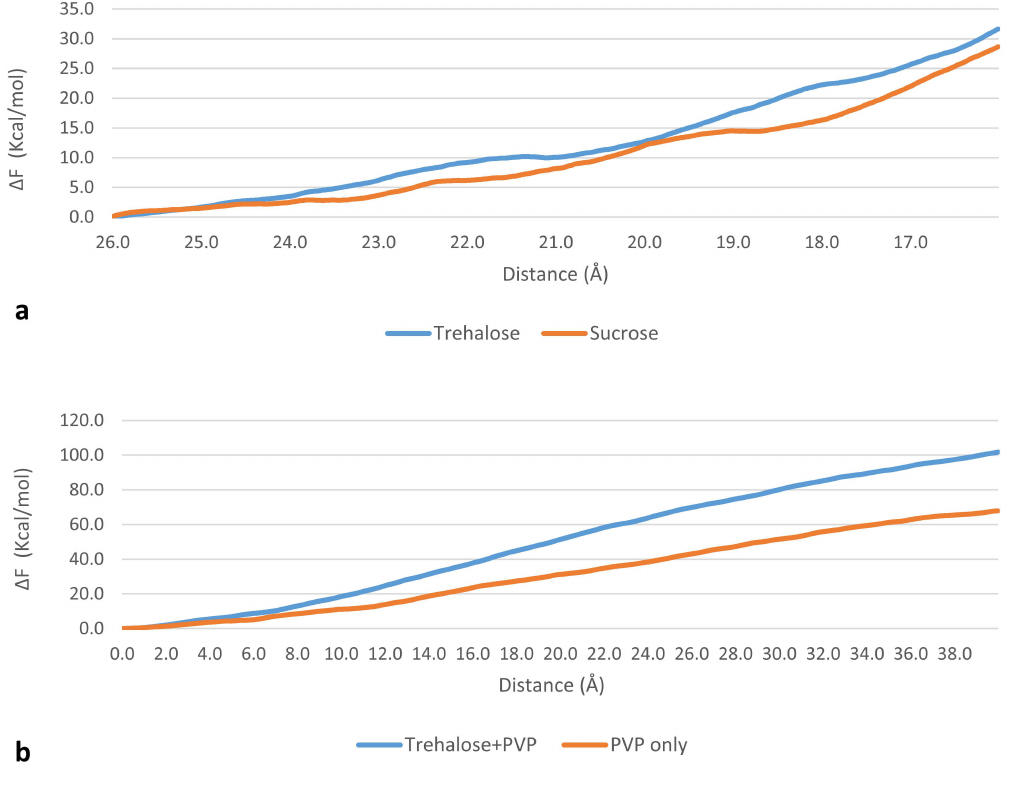
Figure 3. Free-energy di ff erence calculated through Jarzynski equality for ( a ) the process of pulling a sugar molecule from bulk water (d = 26 Å) into the membrane (d < 15.5), showing a higher interaction of trehalose with the bilayer and ( b ) the process of pulling DPPC molecules toward the bilayer’s midplane, showing a stronger interaction of DPPC with a trehalose / poly(vinyl pyrrolidone) (PVP) cluster rather than PVP